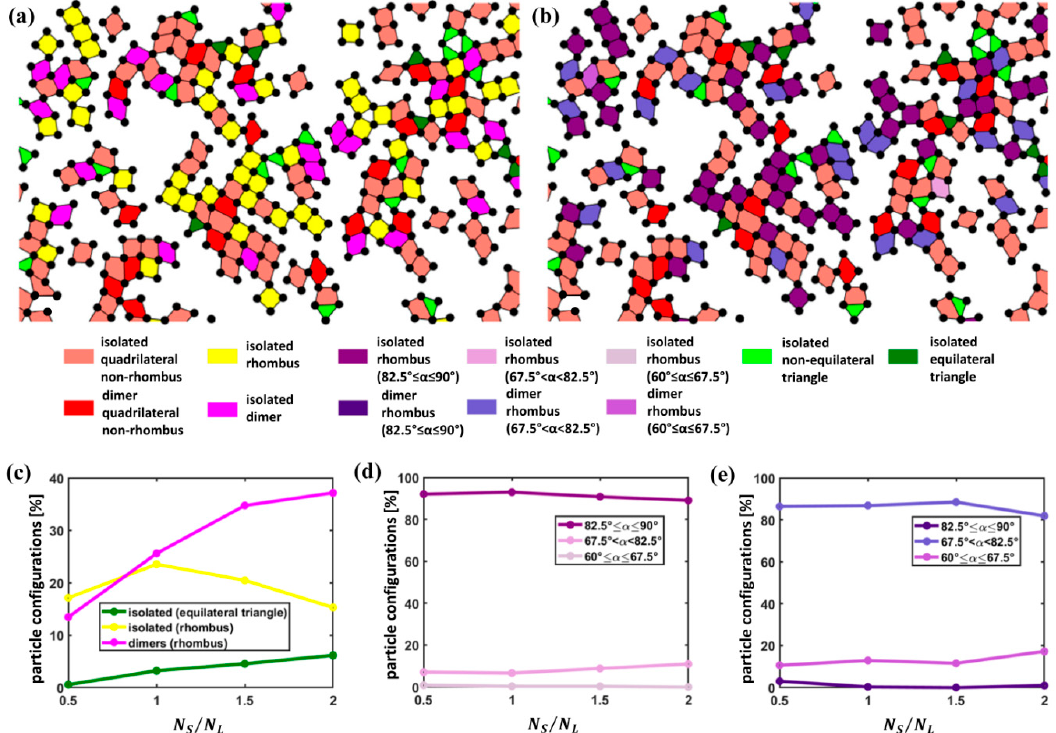
Figure 6. Angular and radial uniformity of quadrilaterals and triangles of L particles with respect to isolated S particles and S particle dimers: ( a ) Identification of isolated S particles involved in equilateral triangles and rhombi and of S particle dimers involved in rhombi; ( b ) classification of rhombi around S particles and S particle dimers according to the angle α ; ( c ) percentage of isolated S particles involved in equilateral triangles and rhombi and of S particle dimers involved in rhombi for variable particle number ratio N S /N L ; ( d ) angle classes of rhombi around isolated S particles for variable particle number ratio N S /N L ; ( e ) angle classes of rhombi around S particle dimers for variable particle number ratio N S /N L